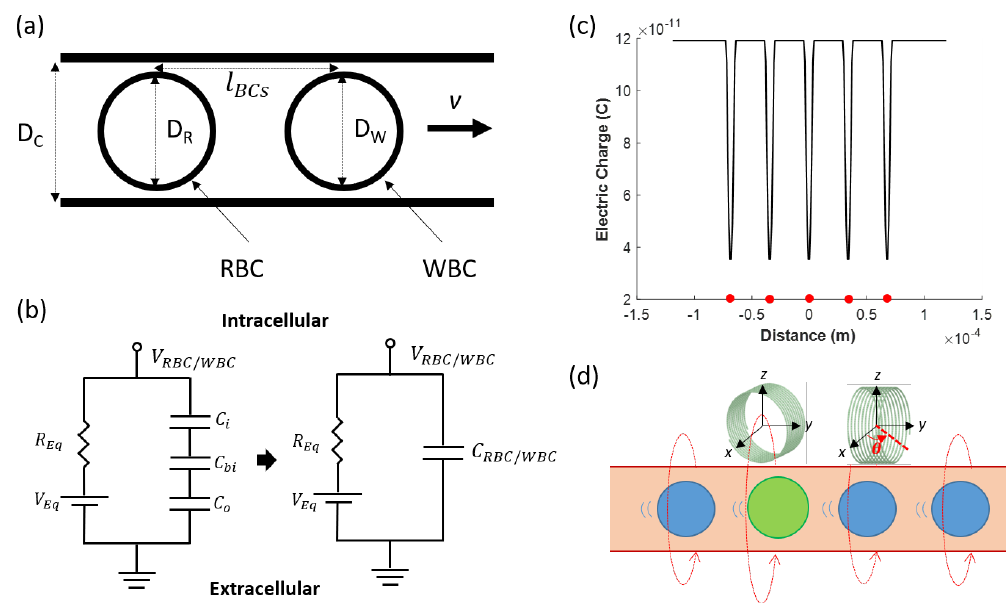
Figure 1. The blood stream and the generation of a magnetic field produced by the electrically charged blood. ( a ) Schematics of blood cells consisting of red blood cells (RBCs) and white blood cells (WBCs) flowing along the capillary with a speed of v . The diameters of the RBC and the WBC are D R and D W, respectively, and each adjacent blood cell is separated by l BCs . ( b ) A cell is modeled as three serially connected capacitors C i , C o , and C bi , reflecting an electrical double layer of intracellular and extracellular regions, and a lipid bilayer, respectively. Capacitors are connected to a resistor ( R Eq ) and a voltage source ( V Eq ), each reflecting ion channels and the equilibrium potential of ions. ( c ) Electric charge along the capillary when RBCs are located at − 68, − 34, 0, 34, and 68 µ m (red-filled circle). The base volume is defined as the volume of the capillary with a 1 µ m thickness along the y -axis. All the charges inside the base volume are summed to determine the electric charge for each point. ( d ) When blood flows in the y -direction, the magnetic field is generated in a counter-clockwise direction in the xz -plane. Among the two microcoils located above the capillary, the left one is aligned to capture the maximum magnetic field (rotation angle ( θ ) of 0 ◦ ), whereas the microcoil on the right is rotated by θ about the rotation axis of z